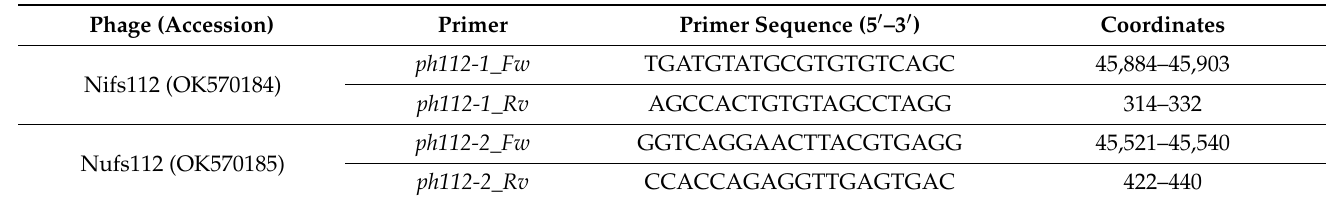
Table 3. Custom primers designed to verify the physical phage genome molecule termini of Pantoea phages Nifs112 and Nufs112.